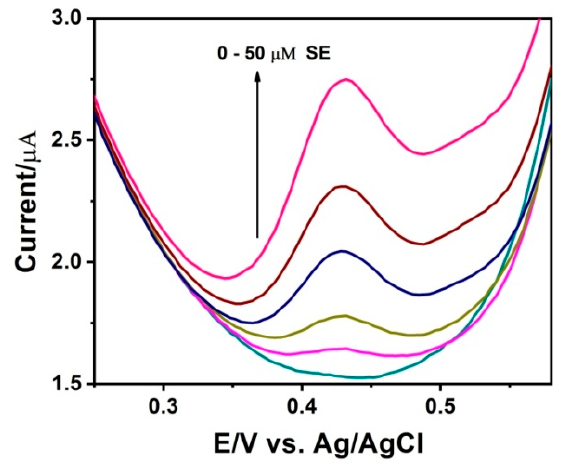
Figure 8. SWVs obtained for blood serum (green line) and after successive addition of SE concentrations to blood serum at the MnO 2 -GR/GCE in 0.1 M PBS. Table 2. Determination of SE in human blood serum sample using MnO 2 -GR/GCE. Sample